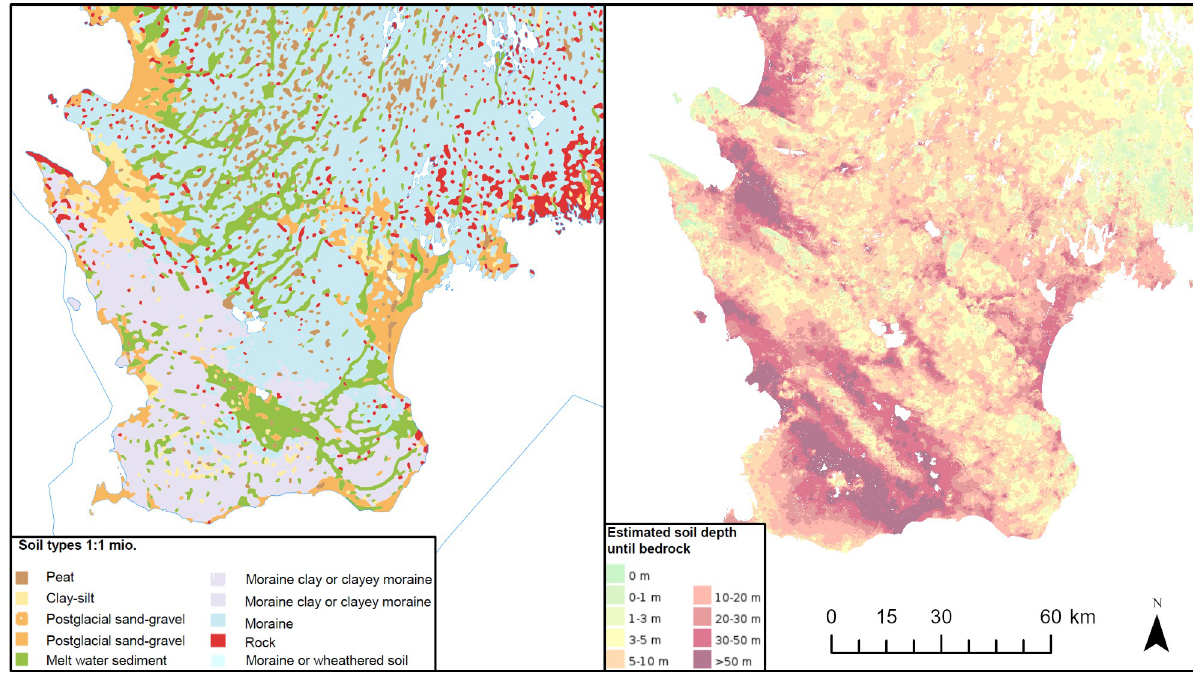
Fig 4. Maps showing soil types and estimated soil depth of Scania. Maps are extracted from the thematic 1:1 mio maps publically available from the Geological Survey of Sweden (www.sgu.se), and generated using ESRI ArcGIS Pro software, licensed to the National Museum of Denmark.